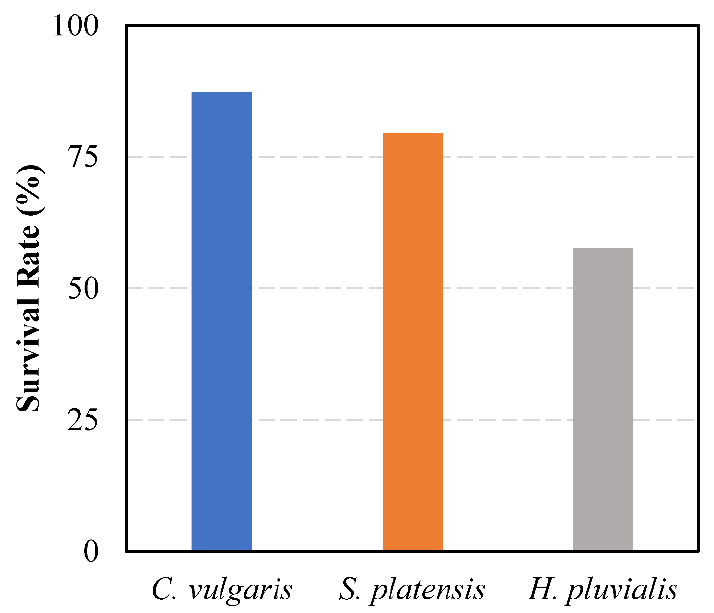
Figure 2. Effect of microalgal biomass (diet) on the survival rate of pearl oyster ( Pinctada fucata martensii ).